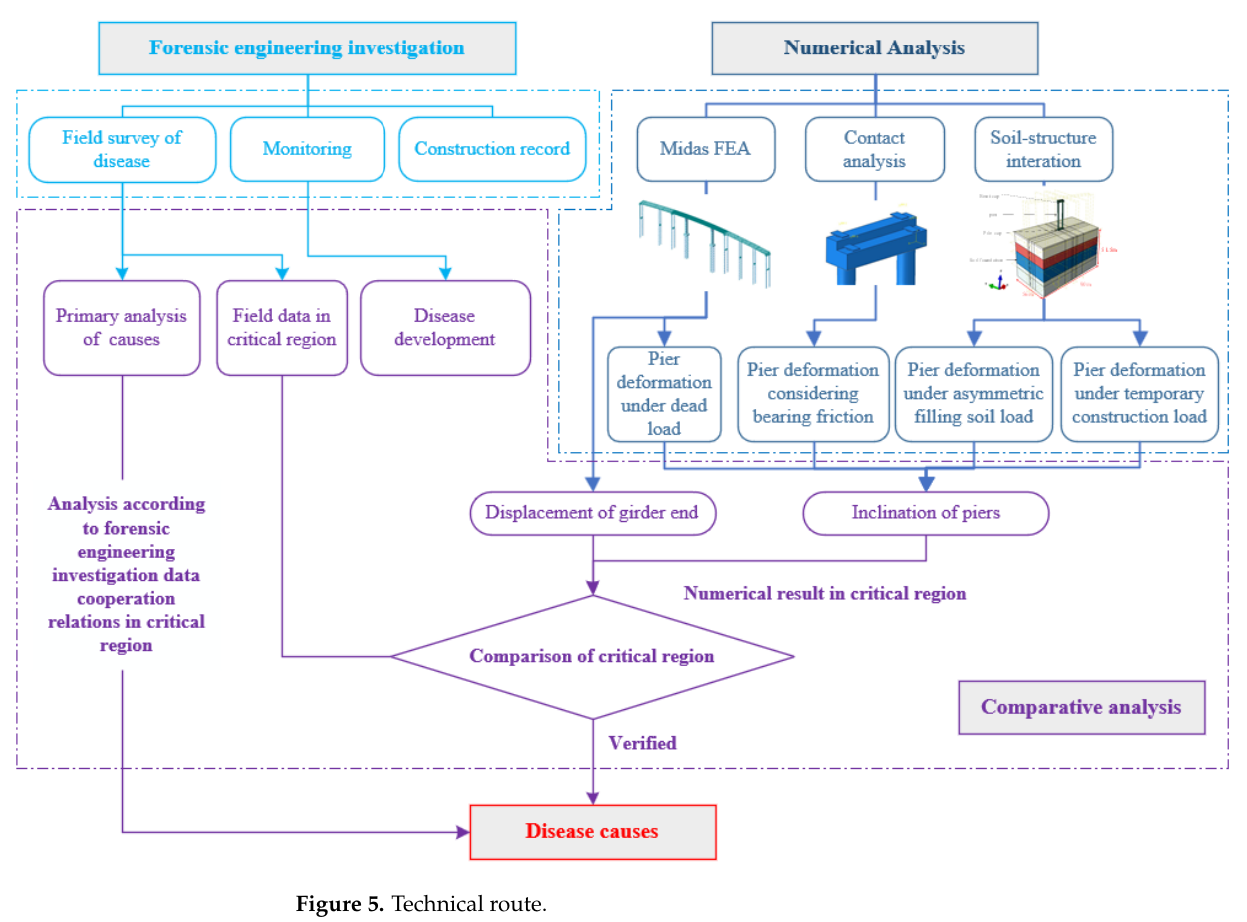
Figure 5. Technical route.